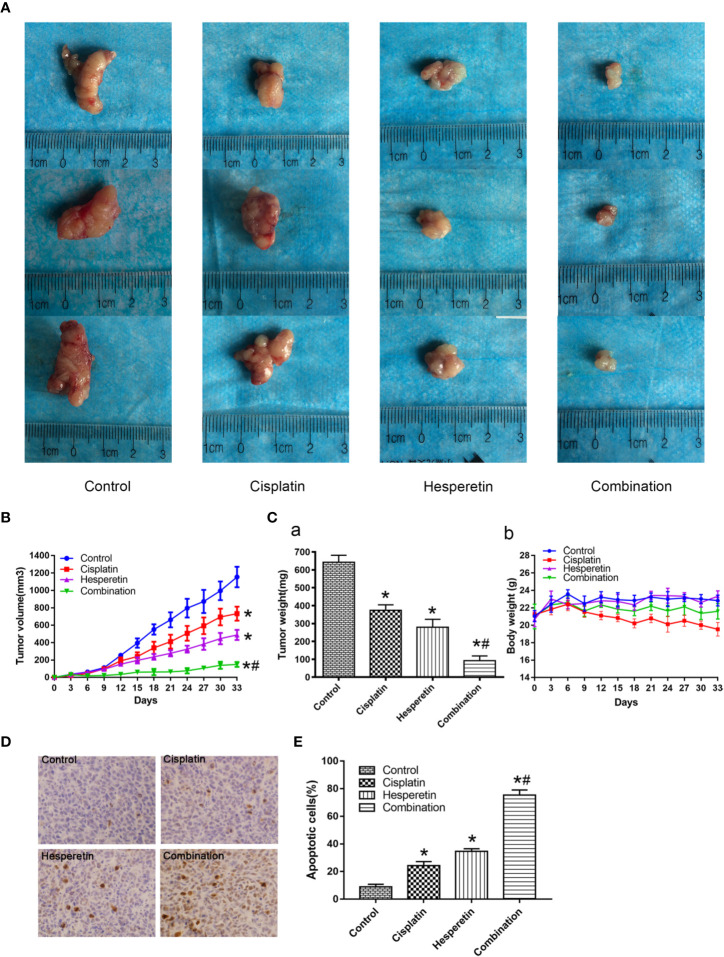
Anti-tumor effects of cisplatin and hesperetin in vivo. (A) Morphology of the subcutaneous implanted tumor. (B) Mean tumor volume at each time point. (C) a. The tumor weight obtained at the end of the experiment. b. The recorded body weights of the mice. (D) A TUNEL assay was performed to detect the apoptotic cells in the tumor tissue. (E) Quantitative analysis of the apoptosis rate in (D). *P < 0.05 vs. the control, *#P < 0.05 vs. cisplatin alone. All the above data are the mean ± SD from an average of three experiments.